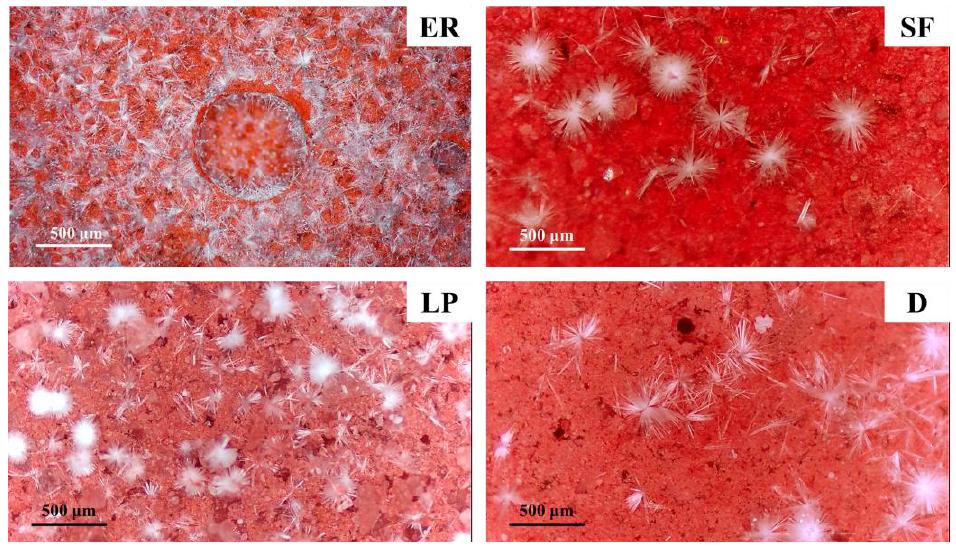
Figure 4. O.M. images of different specimens.